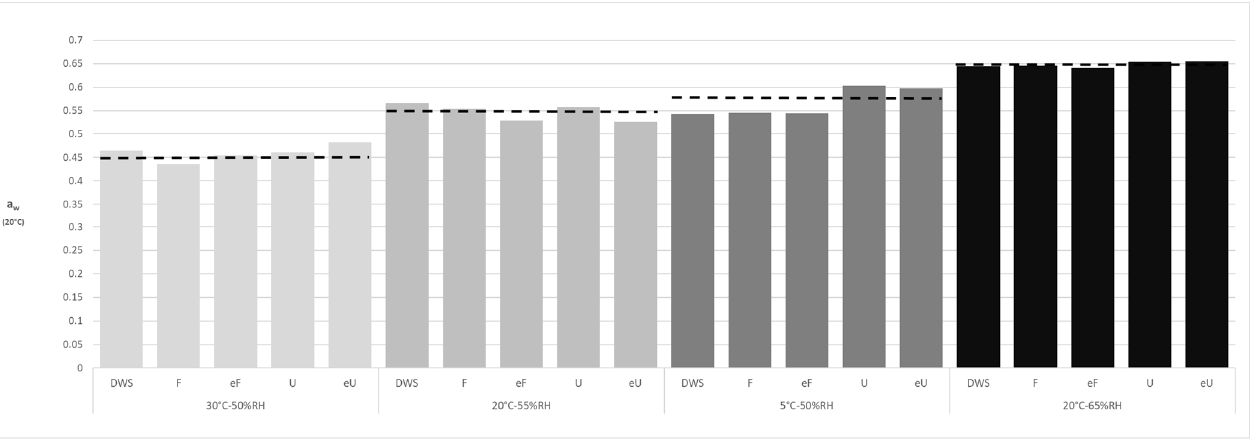
Figure 2. Water activity of pastas after 6 months stored at different temperature and relative humidity conditions at storage. Dashed line indicates the estimated water activity at 20 °C of samples stored at the temperature and relative humidity indicated.